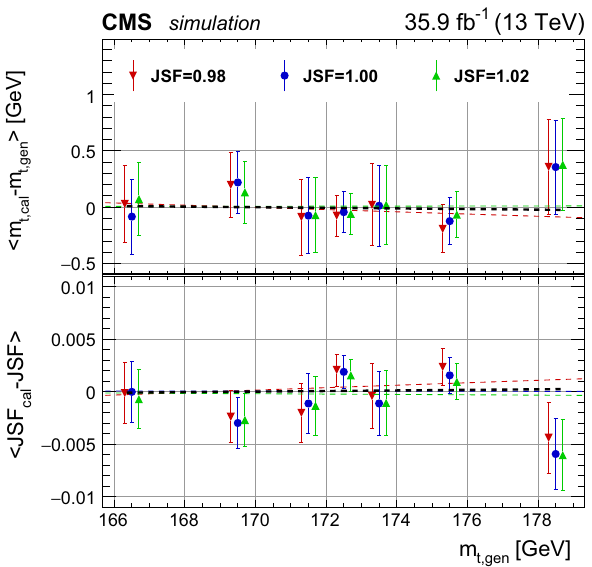
Fig. 3 Difference between extracted and generated top quark masses (upperpanel)andJSFs(lowerpanel)fordifferentinputmassesandJSFs afterthecalibrationintheall-jetschannel.Thevaluesareextractedusing the 2D